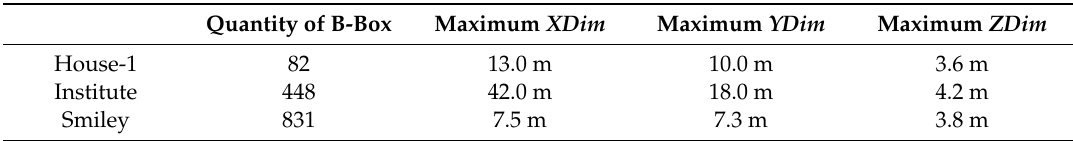
Table 4. Maximum XDim , YDim , and ZDim for bounding boxes (B-Boxes) in House-1, Institute, and